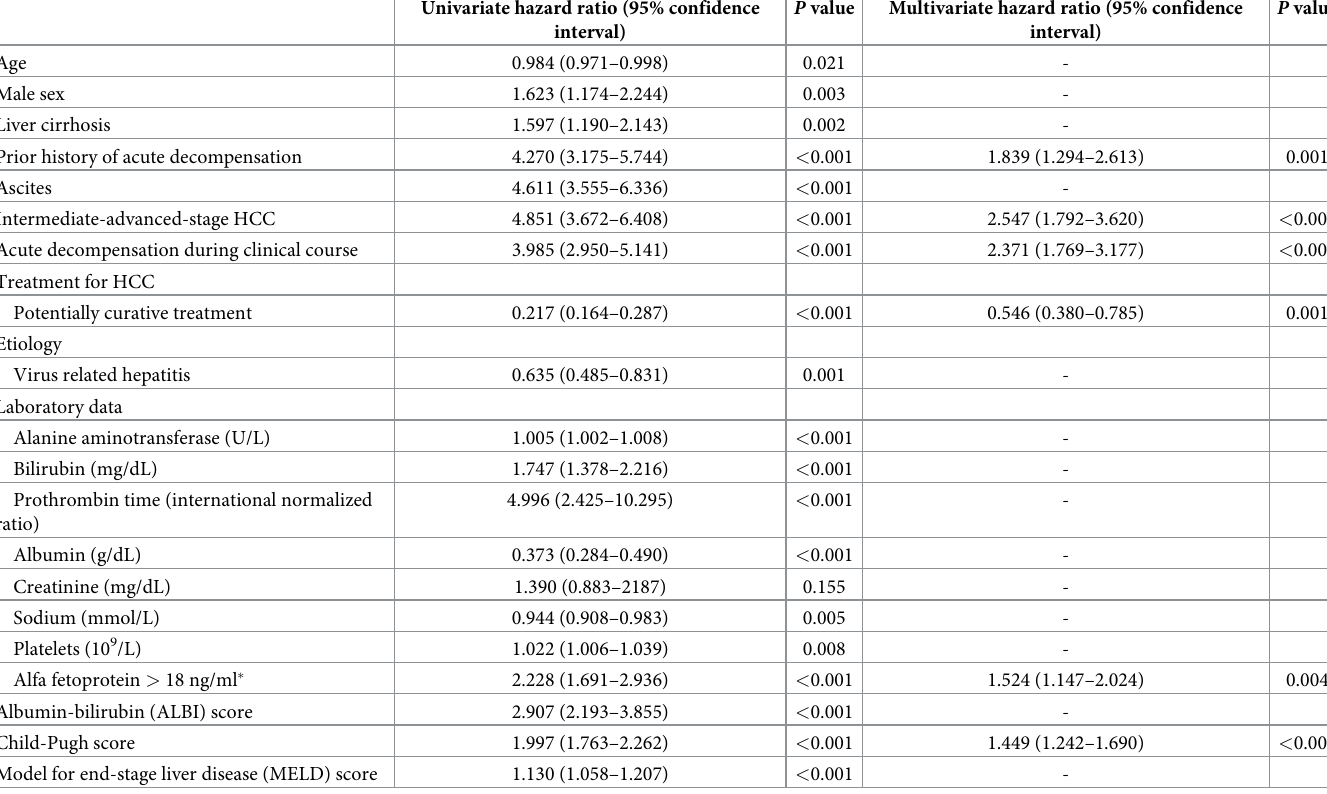
Table 9. Cox regression analyses of prognostic